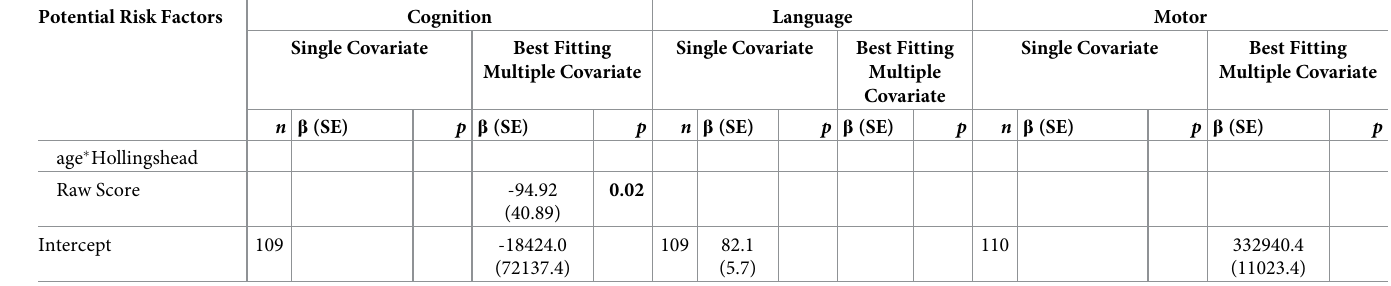
A Spearman-rho correlation matrix of the urinary metabolites concentrations was com- puted. Of the 870 bivariate correlations, 86 (10%) were highly, statistically significant (p � 0.0024, with many correlations ranging from moderate (r = 0.40 to 0.60) to strong (r > 0.60 to 0.97). Phthalate metabolites in particular were more frequently and strongly corre- lated with one other urinary metabolite. These observations suggest that there are likely com- mon sources for certain groups of contaminants. In future analyses, we will determine whether specific exposure profiles reflect unique patterns of device use (S2 Table). Detectable concentrations of some pesticides [4-fluoro-3-phenoxybenzoic acid, trans-3- (2,2-dichlorovinyl)-2,2-dimethylcyclopropane carboxylic acid, and 2-isopropyl-4-methyl- 6-hydroxypyrimidine] were found in only 6, 15, and 26 subjects respectively; and were